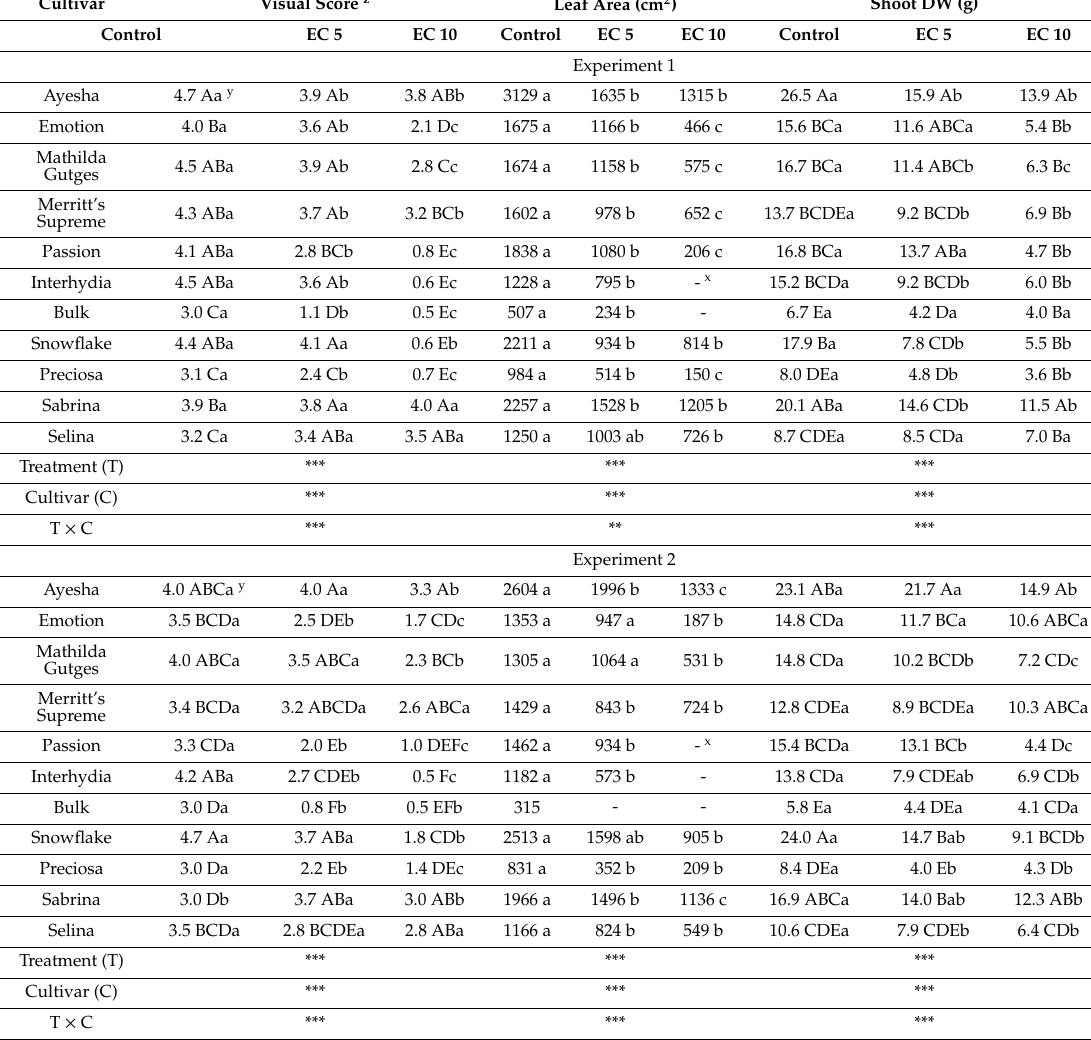
Table 2. Mean visual score, leaf area and total shoot dry weight (DW) of 11 hydrangea